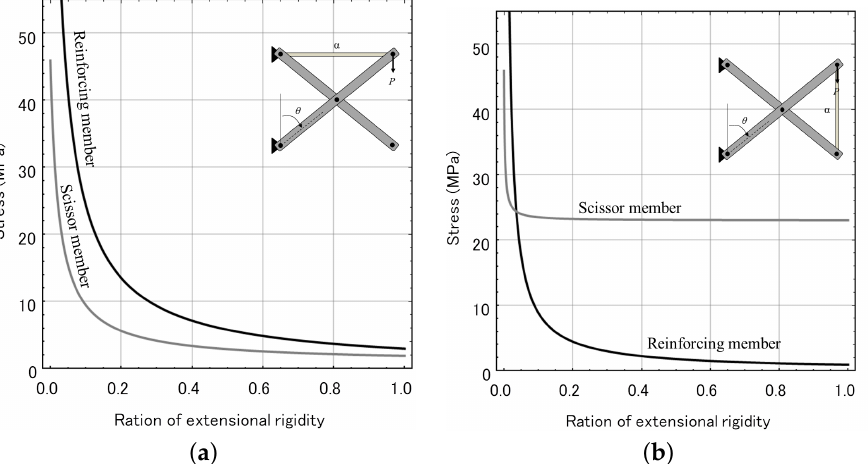
Figure 5. Relationship between the sectional stresses and the ratio of extensional rigidity α : ( a ) model with upper horizontal strut member; ( b ) model with right vertical strut